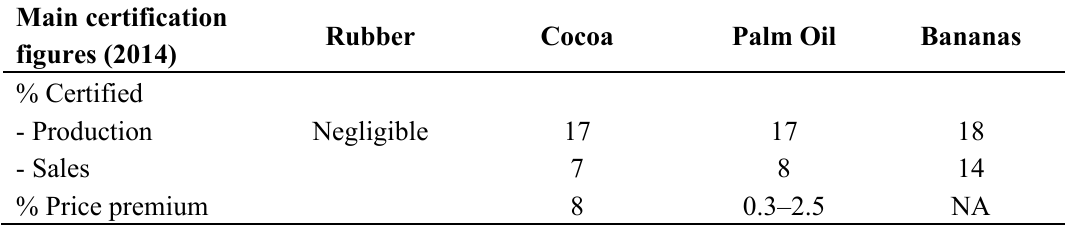
Table 5. Extent of certification for cocoa, palm oil and bananas,